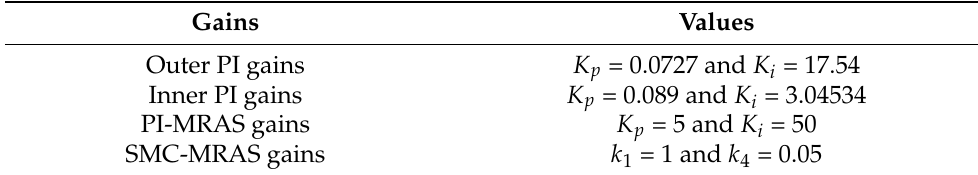
Table 2. Controller